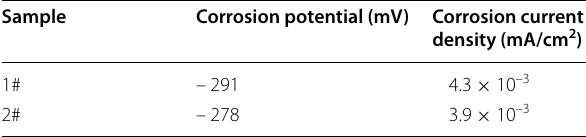
Table 5 Potentiodynamic polarisation results Sample